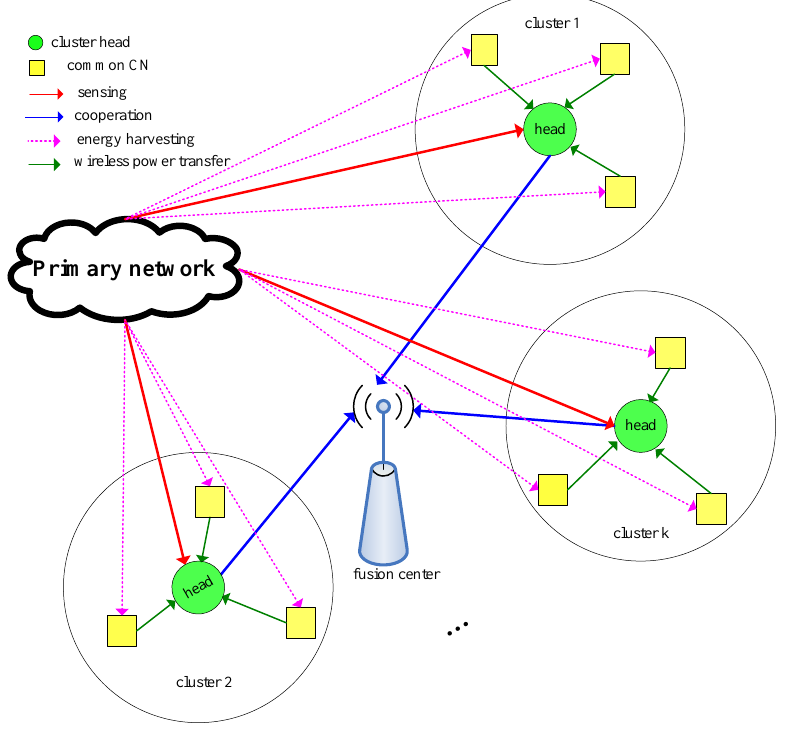
Figure 4. WPT-based clustering cooperative spectrum sensing